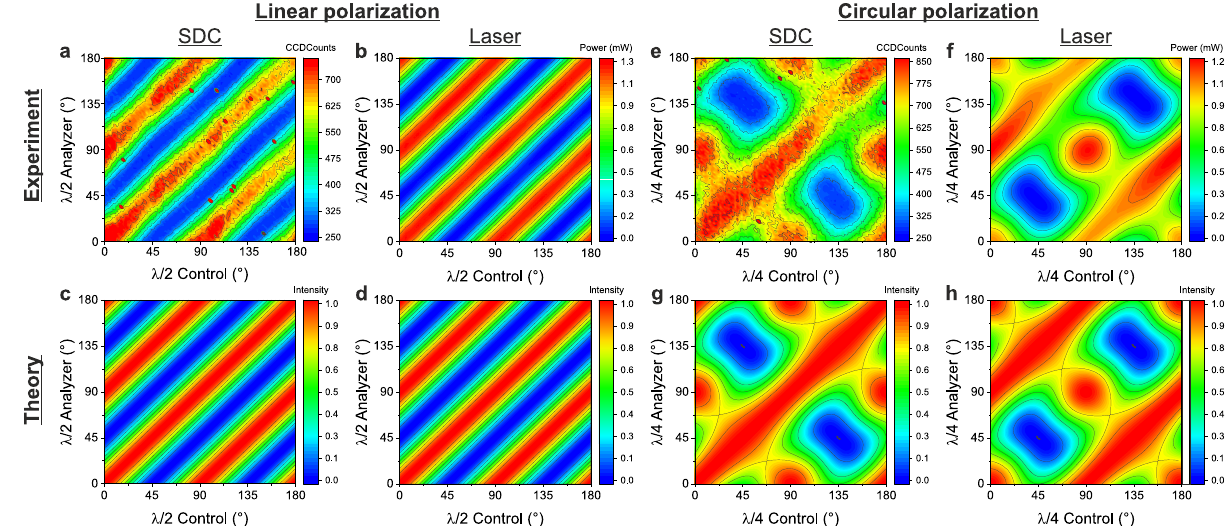
Fig. 6 Polarization control of SDC emission. Intensity of SDC and backscattered control-laser in dependence of angle of the control and analyzer waveplates ( a – d linear polarization, e – h circular polarization) The top row shows experimental results and the bottom row shows corresponding